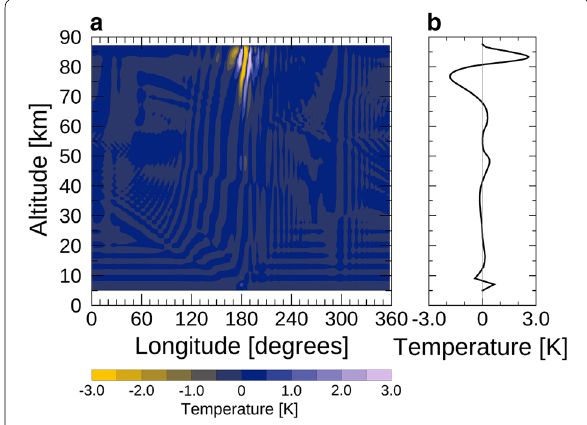
Fig. 5 a Longitude–altitude cross section of the temperature disturbance on the equator for the nominal case shown in Fig. 2. The zonal wind direction is right to left. b Vertical profile of the temperature disturbance just above the position of the wave forcing. Note that regions of 3 K and above were filled with purple, and regions of 3 K and below were filled with yellow ( a −